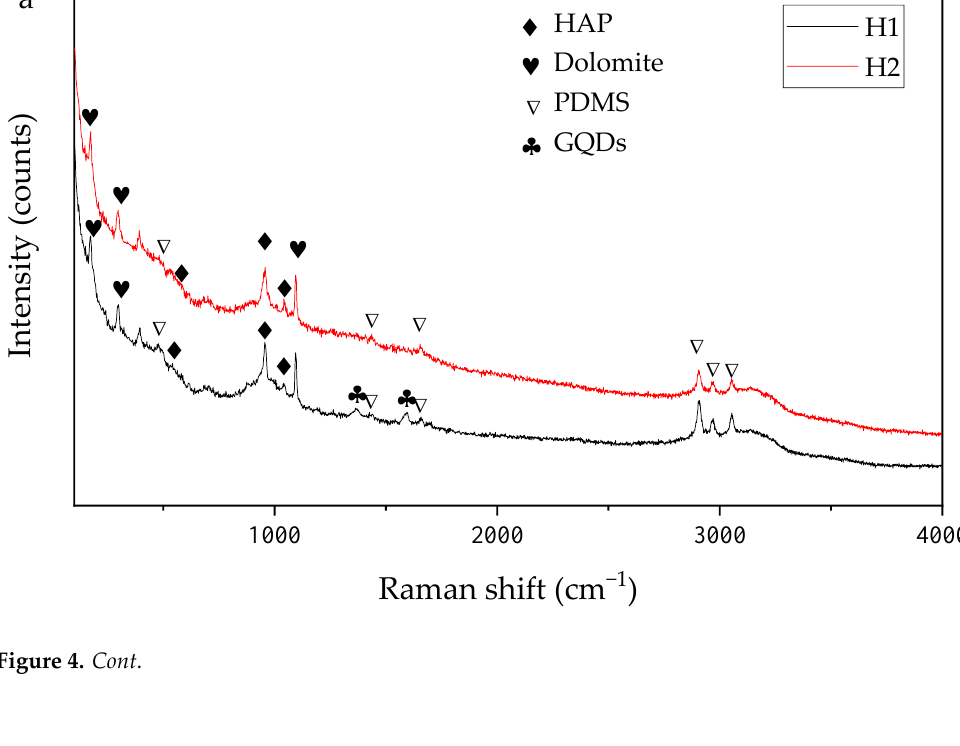
Figure 3. FESEM‑EDS images of cross section ( a ) FESEM micrograph of H1 cross section; ( b ) Distribu‑ tion of Ca, P, O, and Si at H1 cross section; ( c ) FESEM micrograph of H2 cross section; ( d ) Distribution of Ca, P, O, and Si at H2 cross section.